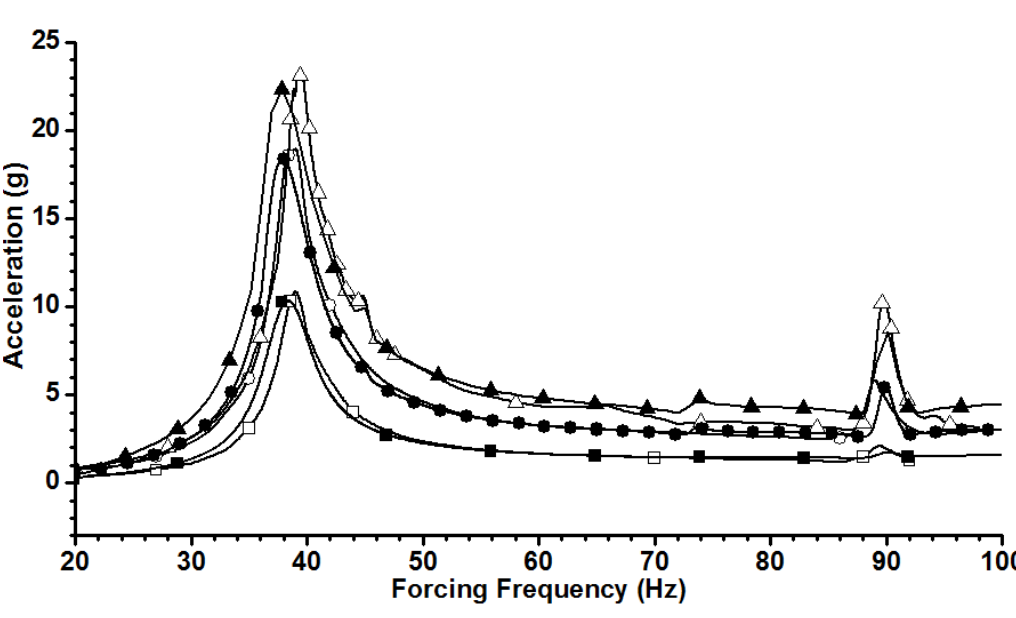
ferent locations and forcing frequencies. The participation of second harmonic is significant in response at location B for ω F = 14 Hz and that at location A for ω F = 23.8 Hz. The steady state response history depicts the significant differ- ences between amplitudes of positive and negative half cy-